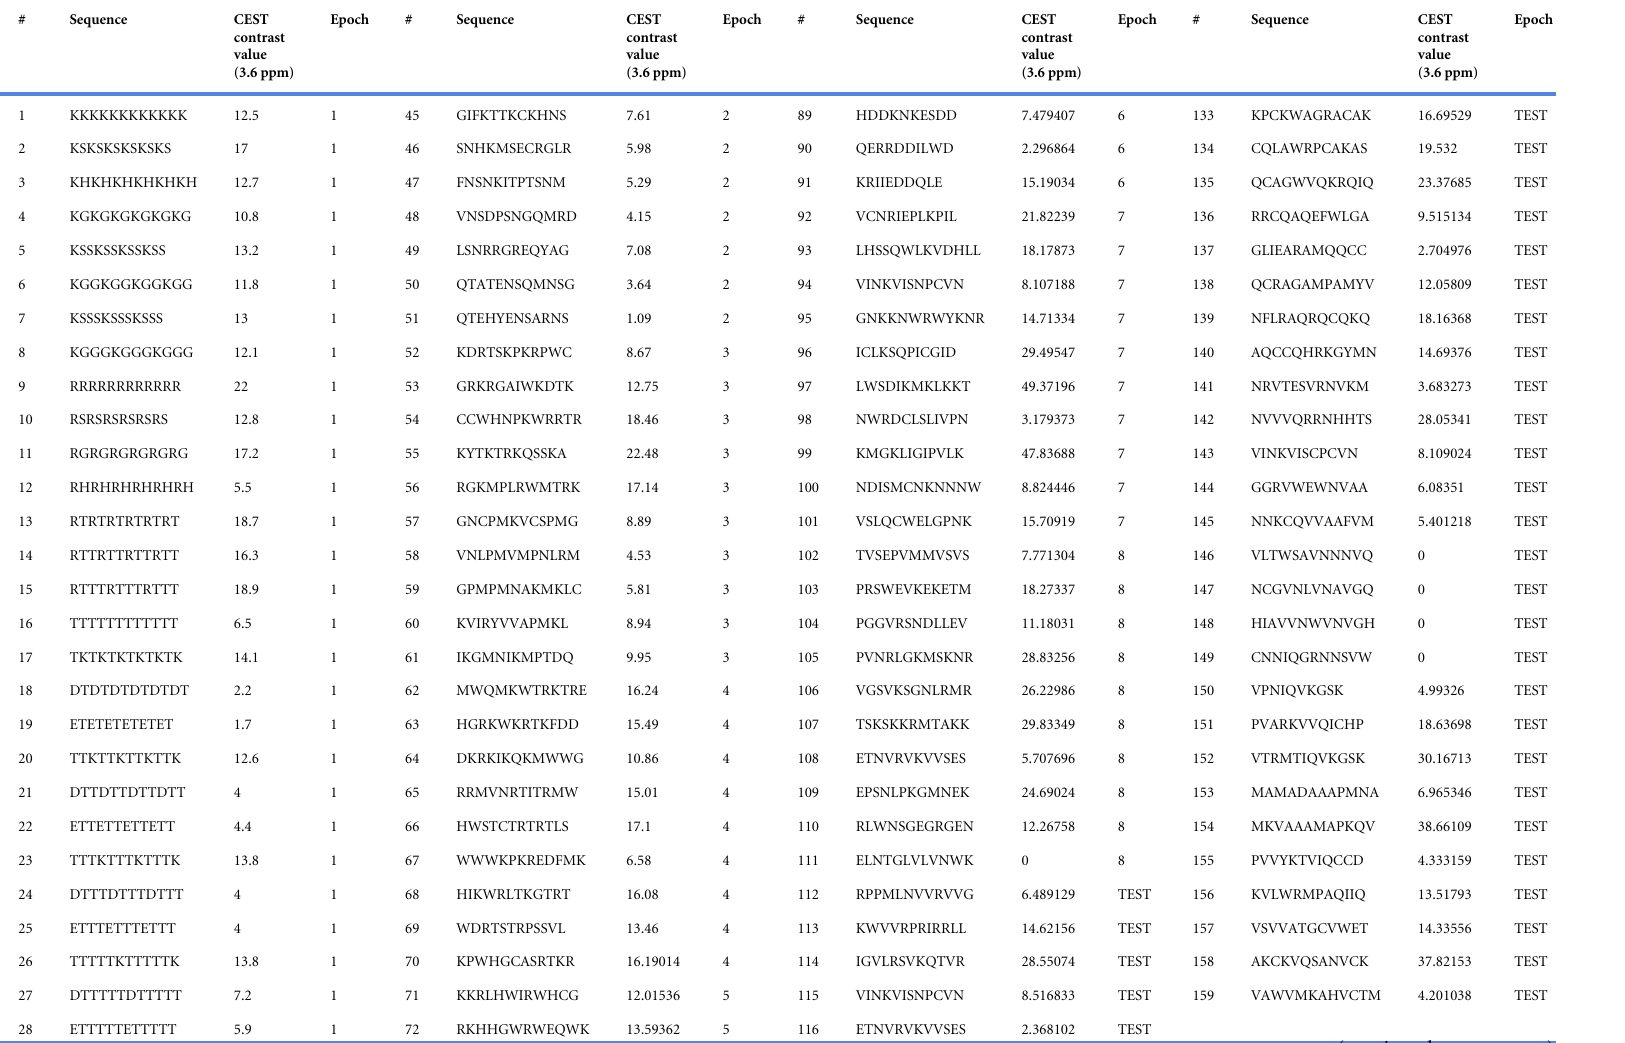
Table 2 All the available data in the dataset used for all the epochs of POET including the mock test data and the discovered protein sequences. All the data points with epoch N and less than N were used to evolve models and predict the data points marked as N +